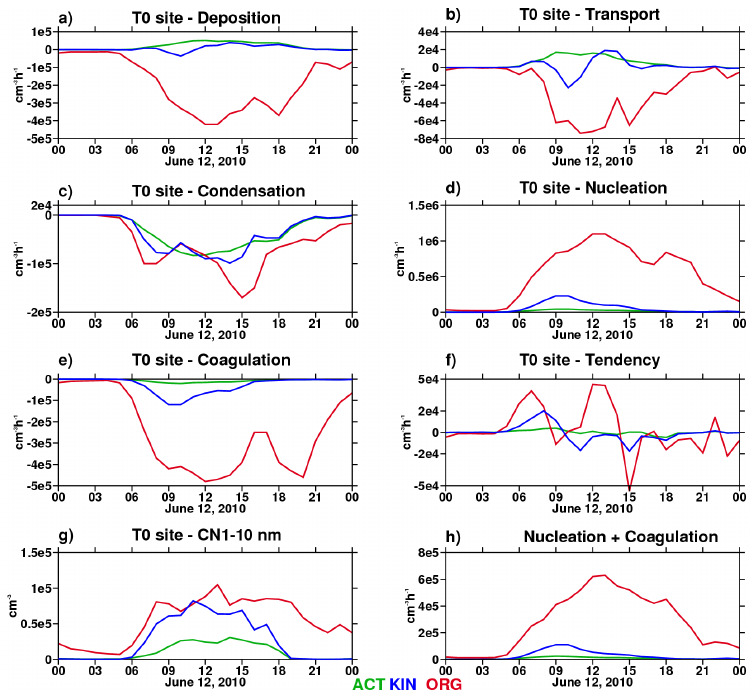
Figure 15. Budget diagnostic terms for 1–10nm particles at the T0 site on 12 June: (a) deposition; (b) transport; (c) condensation; (d) nucle- ation; (e) coagulation; (f) total tendency; (g) particle number concentration in the 1–10nm range; and (h) tendency of particles coming from nucleation and coagulation processes.